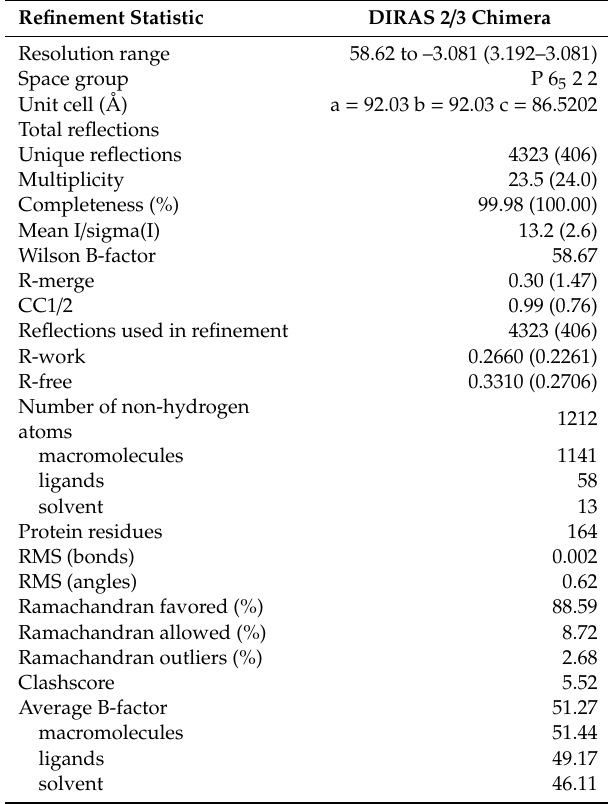
Table 1. Refinement statistics for DIRAS2 / 3 Chimera X-ray